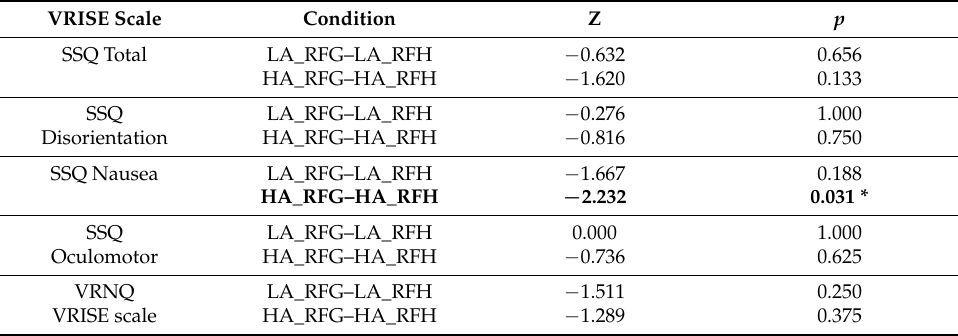
Table 18. Wilcoxon signed-rank test for VRISE scores between the rest-frame conditions for partici- pants who had normal vision and did use distance spectacles or contact lenses (during the experiment, they were wearing contact